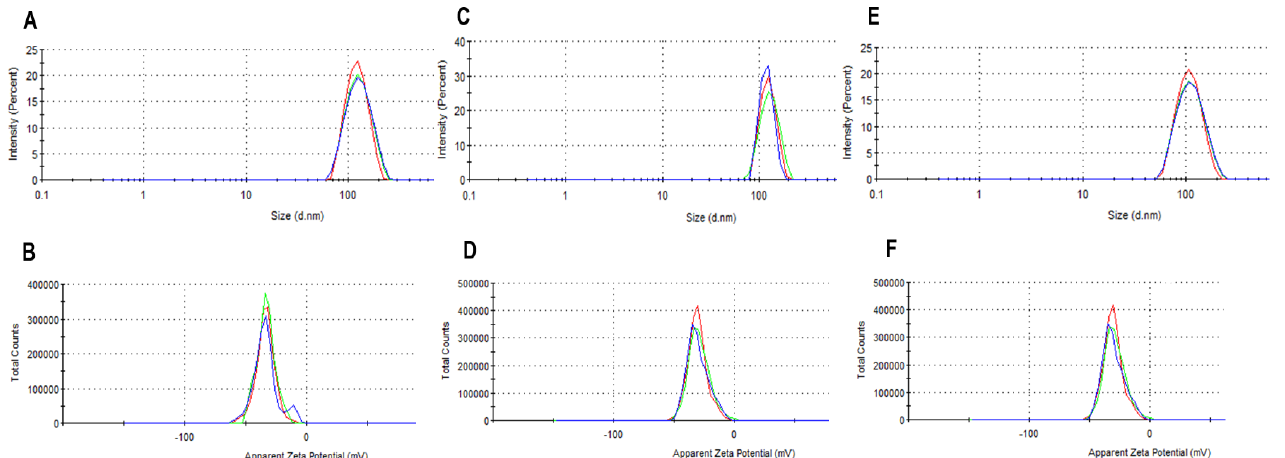
Figure 12. The effects of liposomal co-administration of SIM and DOX on the proliferation of C26 murine colon carcinoma cells co-cultured with murine macrophages. The results show cell prolif-